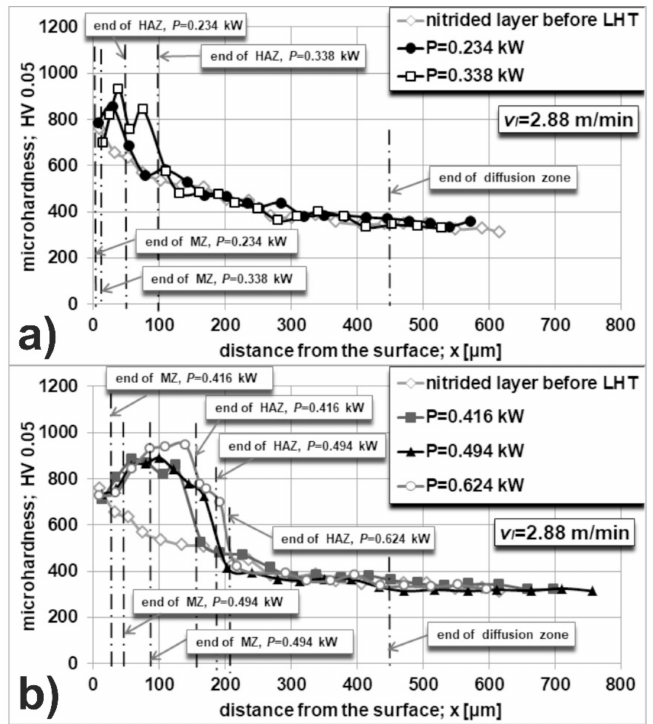
Figure 10. Microhardness profiles in single laser tracks produced on gas-nitrided 42CrMo4 steel using a scanning rate v l = 2.88 m · min − 1 and di ff erent laser beam powers: P = 0.234 kW and P = 0.338 kW ( a ); P = 0.416 kW, P = 0.494 kW, and P = 0.624 kW ( b